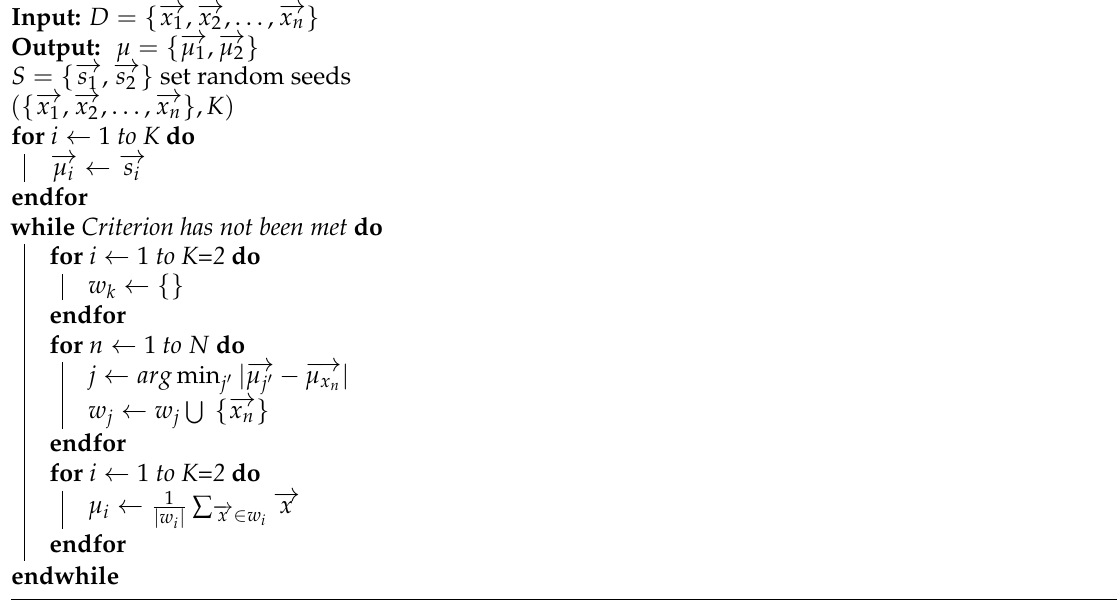
Algorithm 1 K-means algorithm for 2 clusters medical